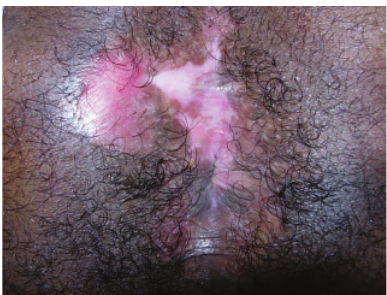
Figure 2 - Proctologic exam after